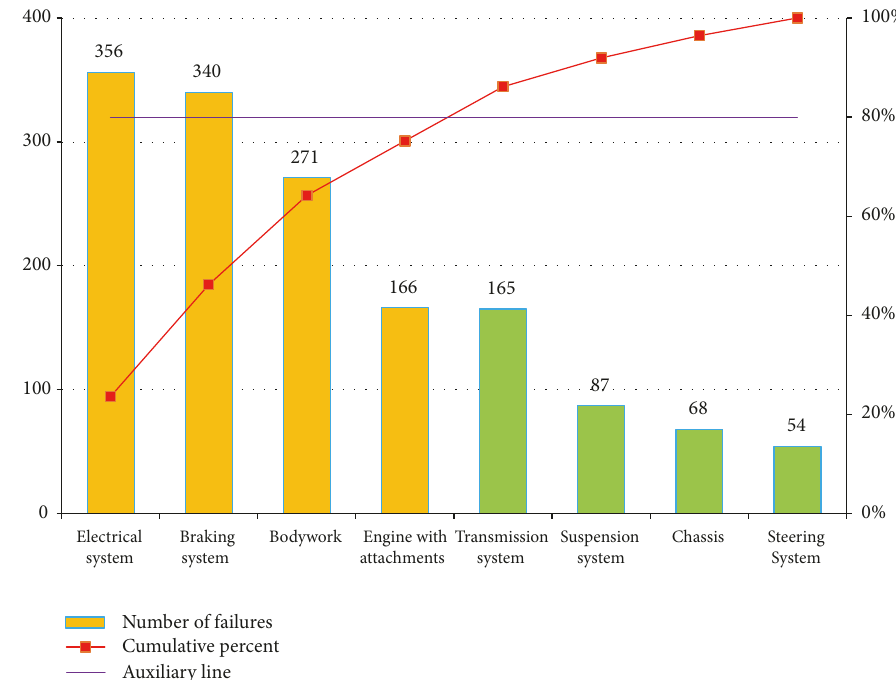
Figure 2: Pareto-Lorenz diagram of damage to individual bus systems based on the control sheet.